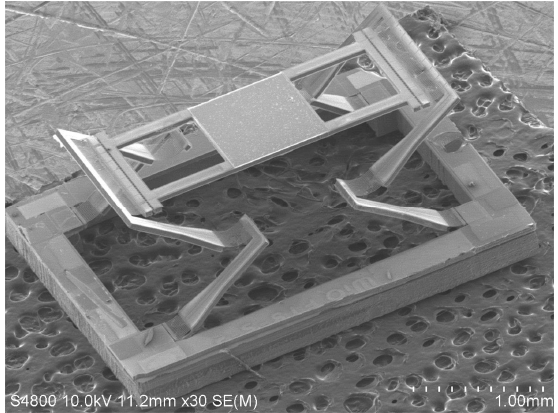
Figure 4. An SEM of a fabricated MEMS mirror.